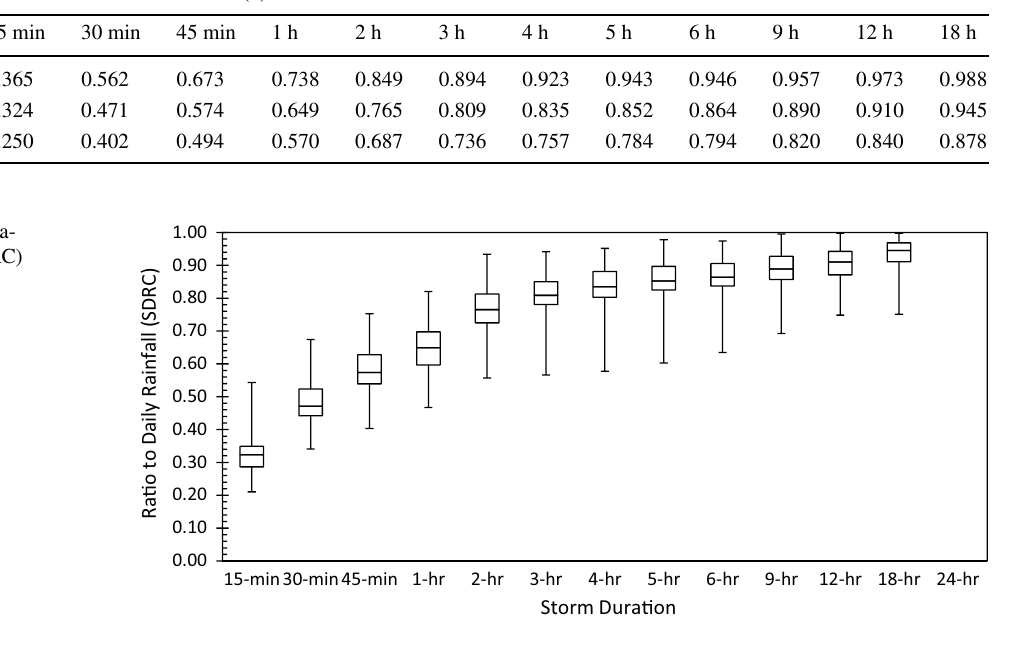
Table 3 SDRC values for the Klang Valley Envelop curve SDRC values for the duration (h) of